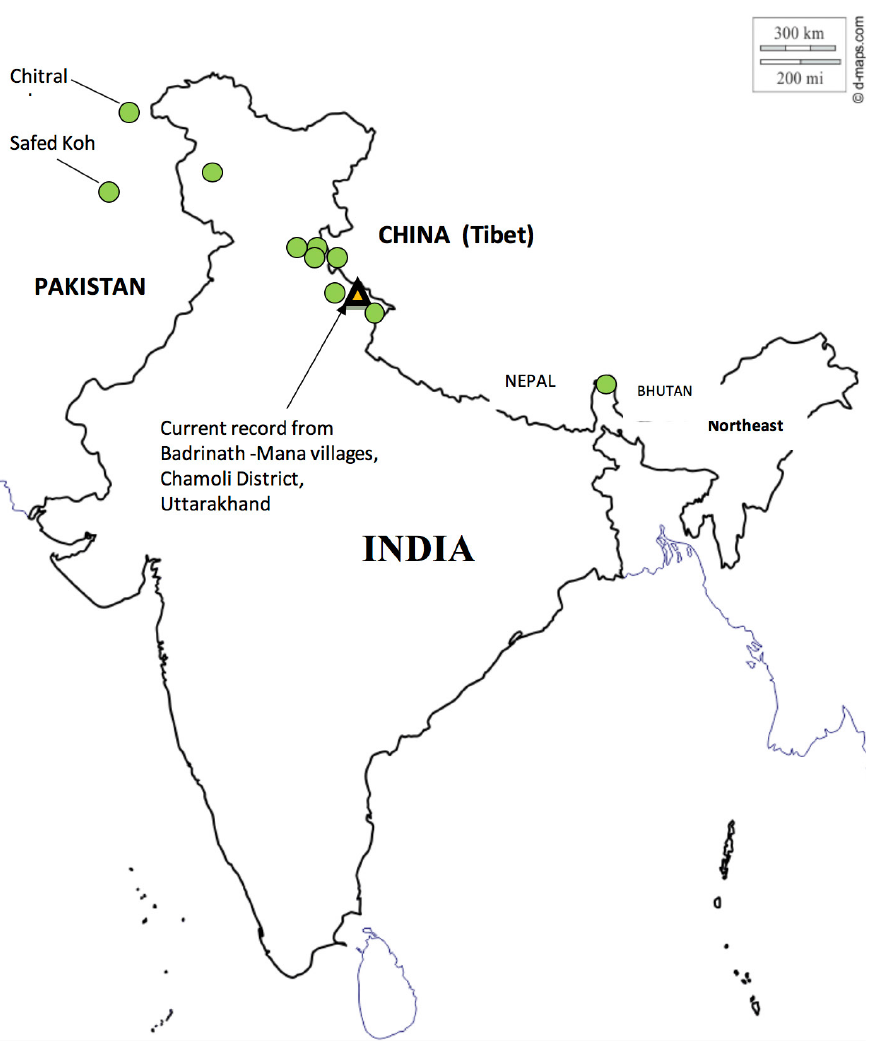
Figure 1. Map depicting the present record of Mountain Tortoiseshell Aglias rizana (Moore, 1872) in Badrinath-Mana area, Chamoli District, Uttarakhand (Garhwal Himalaya) in relation to past confirmed records of the species across other areas in the Himalaya in India and